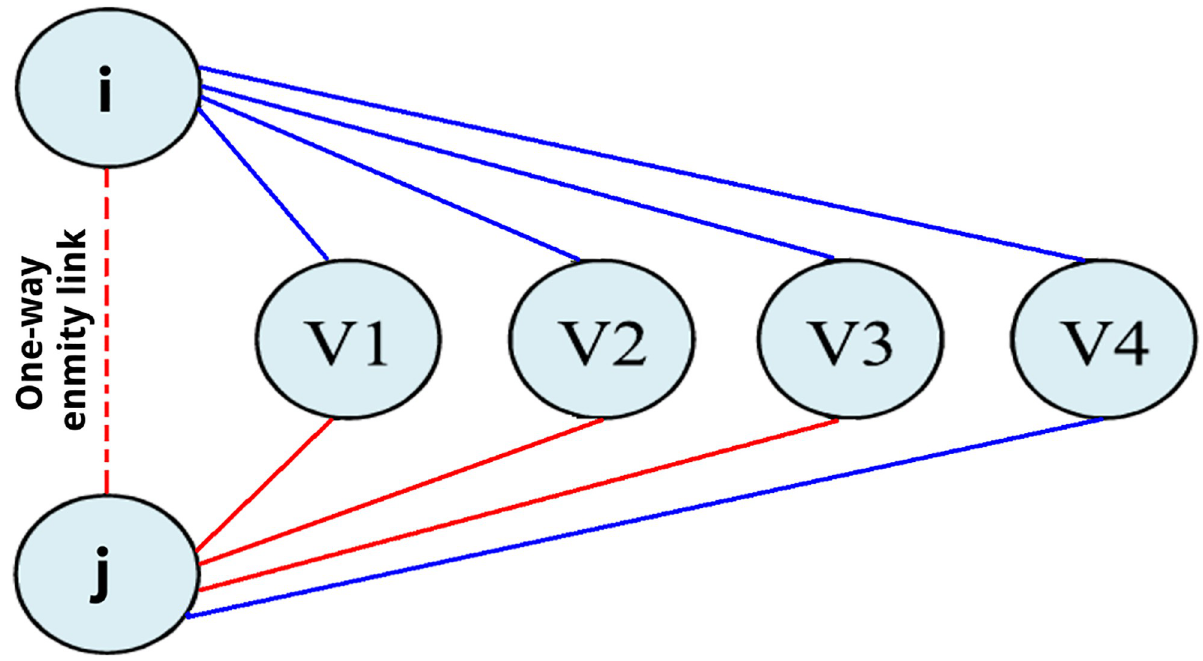
Fig 2. Heuristic to add negative missing links. Blue and red links represent reciprocal friendship (best friend) and enmity (worst enemy) relations respectively. The red dotted line represents a one-way negative link (enemy), that is, only one student said he was an enemy of the other. The figure shows that, if it were reciprocal, there would be three balanced triads and one unbalanced. In this case, the one-way negative link becomes reciprocal negative link. Modified image from [35].